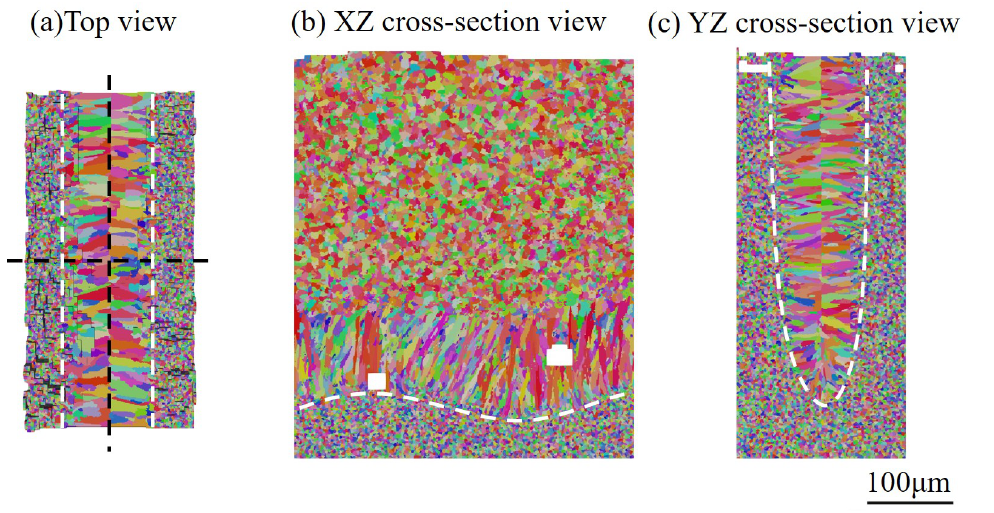
Figure 24. Two-dimensional views of simulation results under the keyhole mode melting: ( a ) top view, ( b ) transverse cross-section map, and ( c ) longitudinal cross-section map, where white dotted lines represent the boundary of the melting zone and black dotted lines represent the location of the